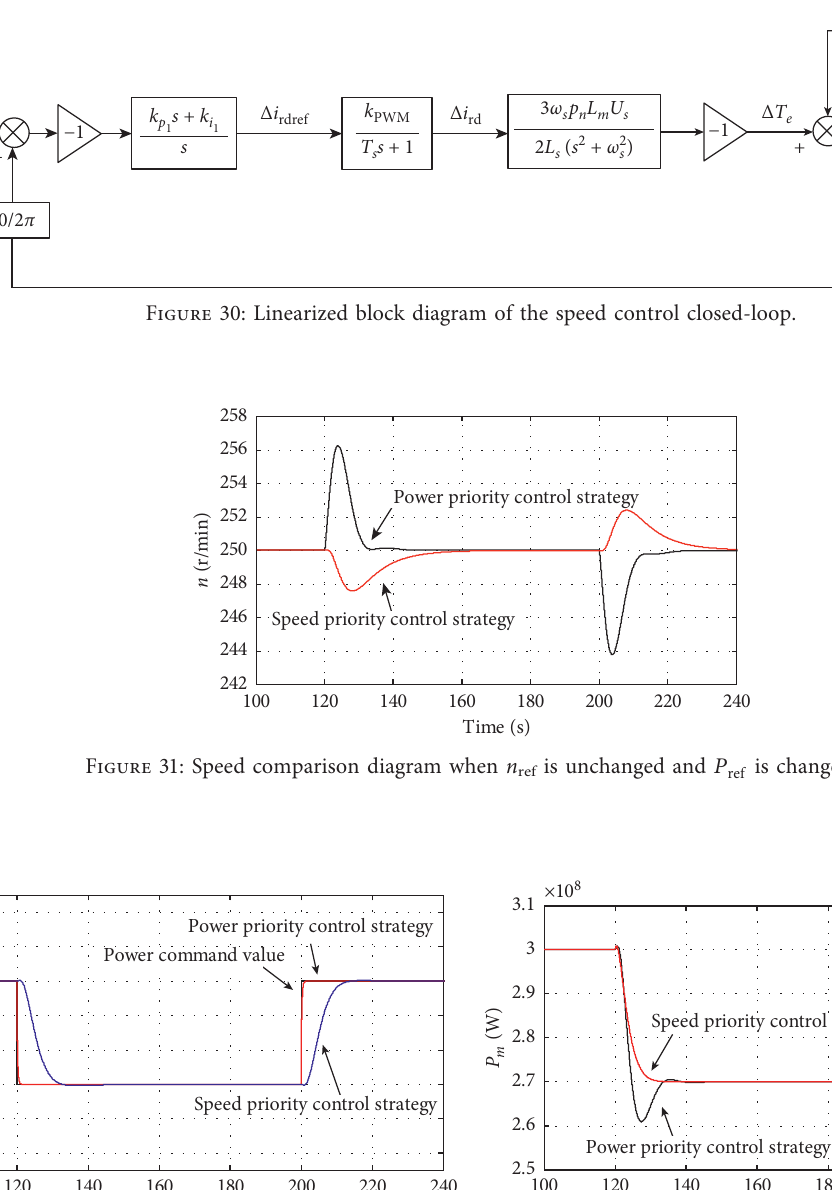
P is changed. (a) Comparison diagram of the stator-side active ref is unchanged and ref